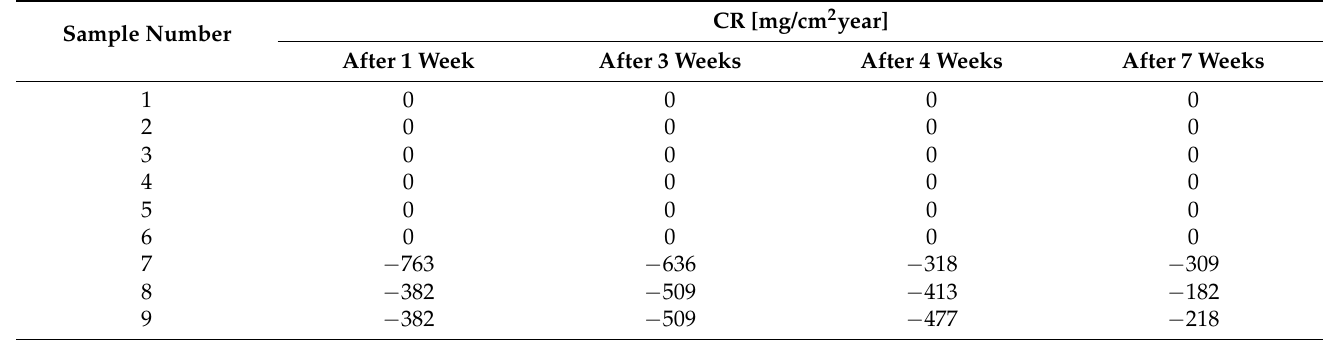
Table 4. Calculated corrosion